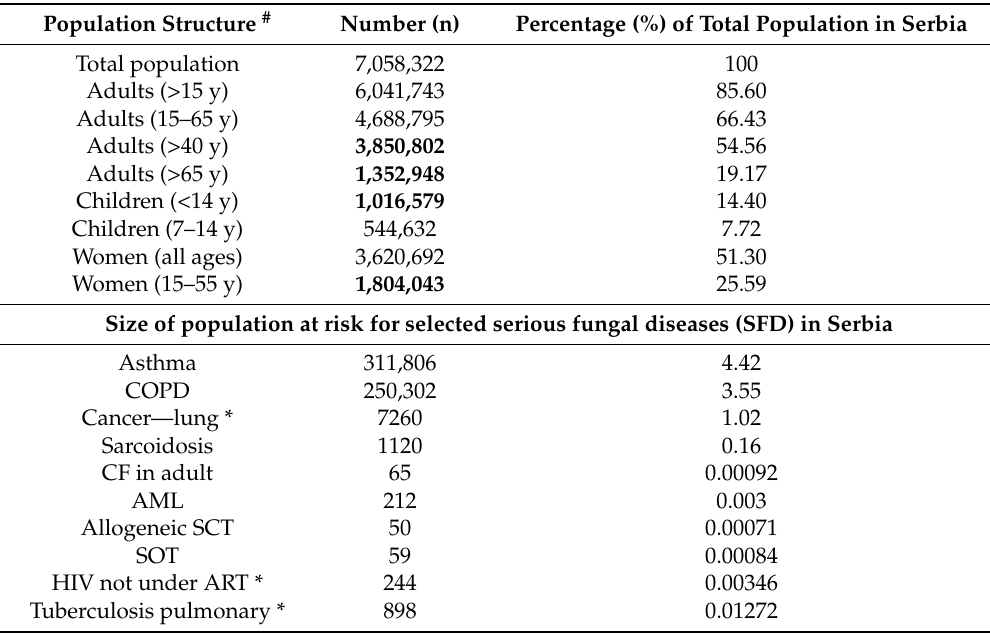
Table 1. Demographic characteristic and size of population at risk of serious fungal diseases in